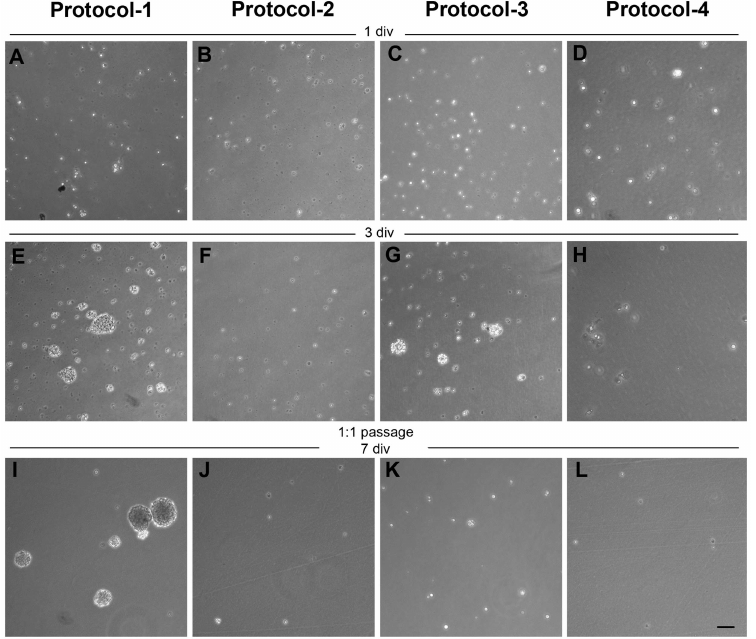
Fig 3. NS cultures of MGE-derived precursors after cryopreservation. (A-D) Phase-contrast photomicrographsof thawed cells plated 1 day in vitro (div) in the presenceof completeserum-free expansion medium. After 3 div, cells from protocol 1 (E) and 3 (G) were able to form NS. In contrast, cells from protocol2 (F) and 4 (H) did not proliferate.Cells from protocol-1(I) were able to form secondary NS after a 1:1 passage and 7 div, whereascells from other protocolsprogressivelydied (J-L). Scale bar 100 μ